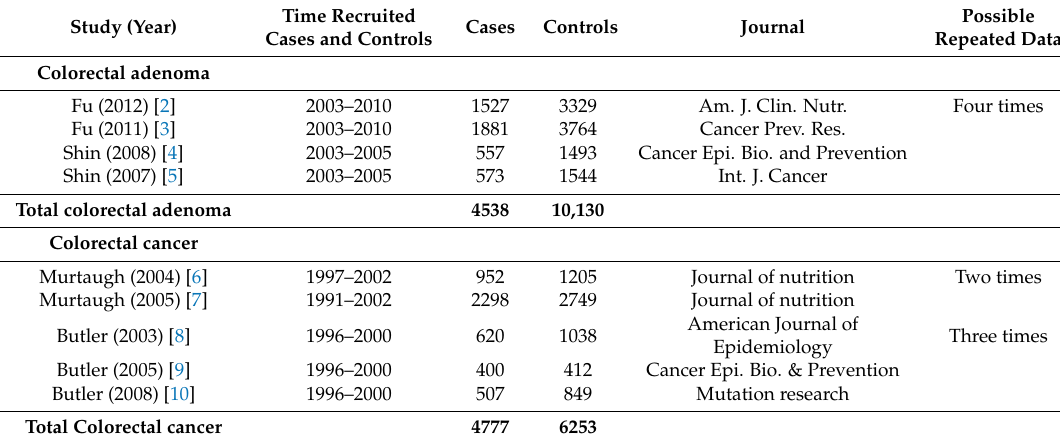
Table 1. Repeated examination and possible repeated